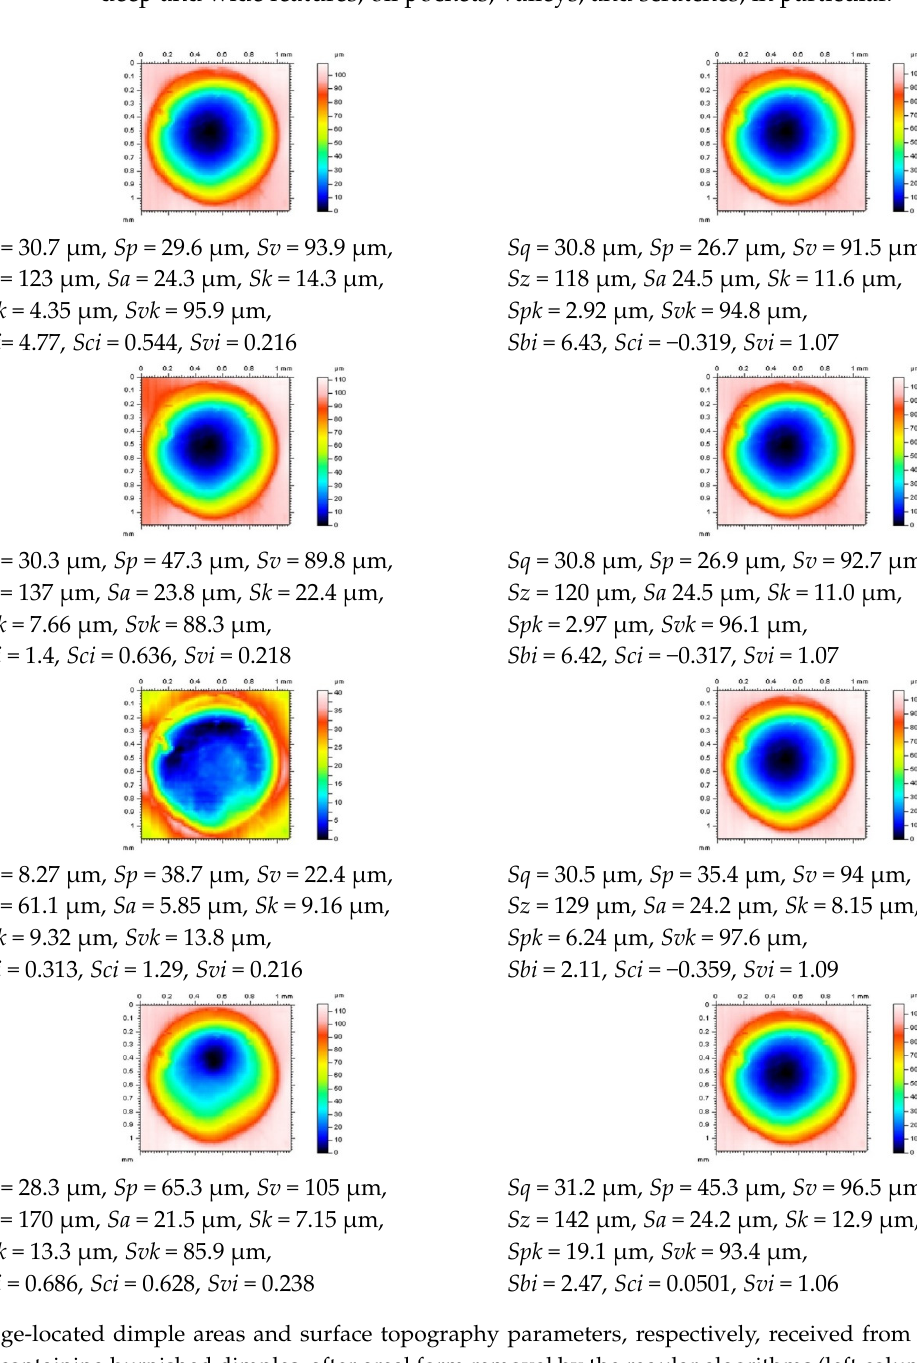
( g , h ) Gaussian filter, cut-off = 0.8 mm, regular algorithms (left column) and modified procedures with a thresholding method (right column).